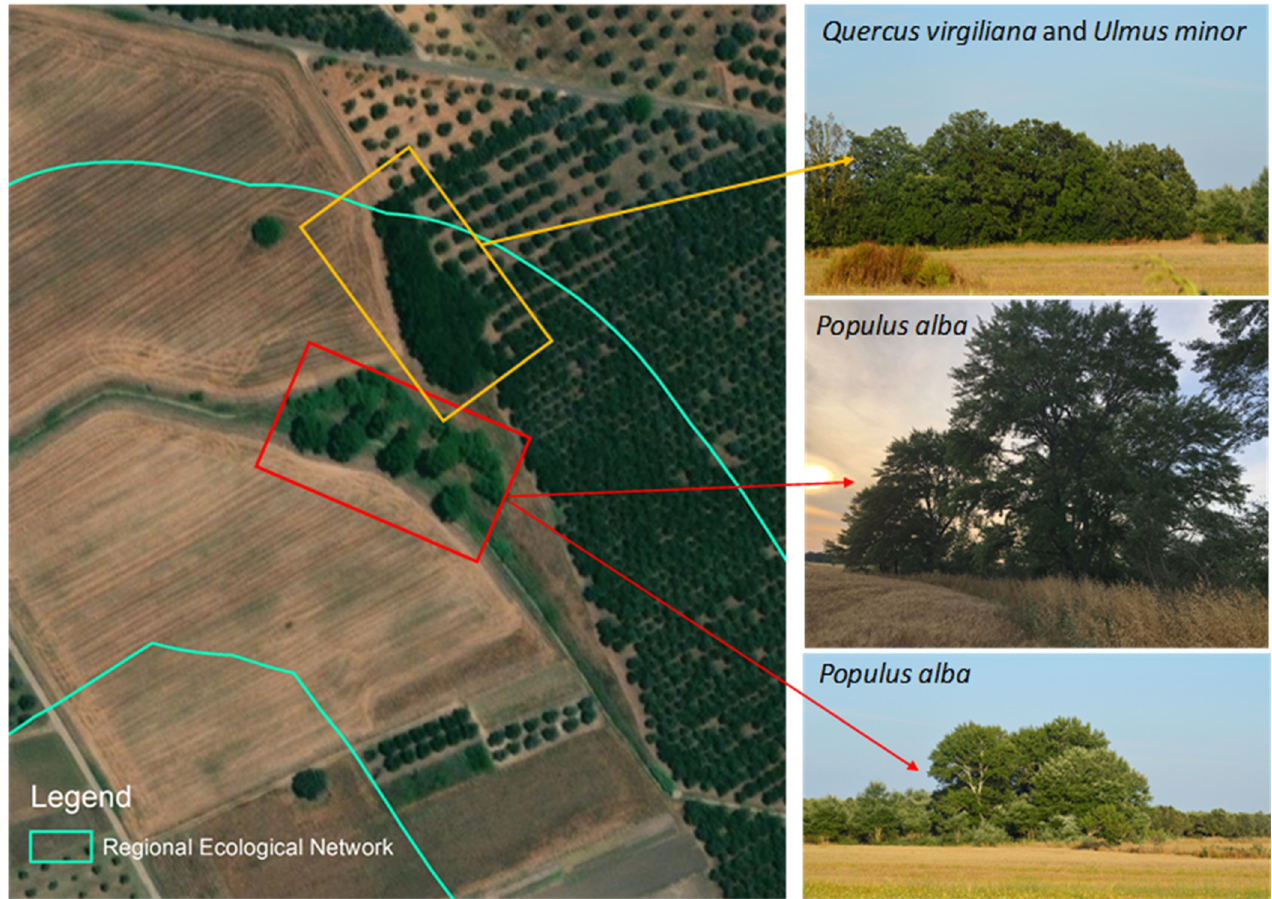
Figure 4. A “biodiversity heritage relict” in the Municipality of Campi Salentina.